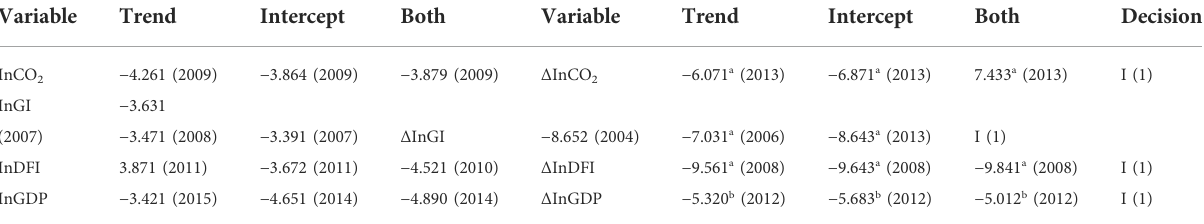
TABLE 4 Zivot and Andrews unit root test results.